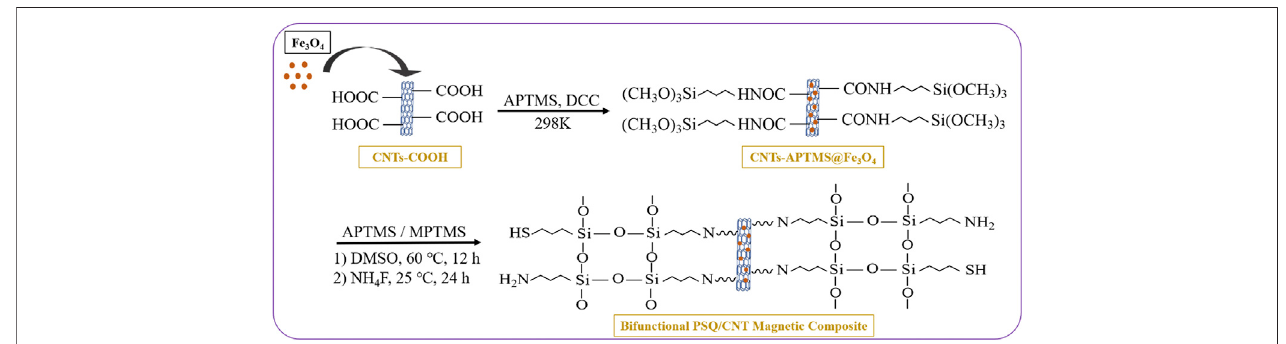
FIGURE 1 | Illustration for the synthesis of bifunctional PSQ/CNTs magnetic composites.